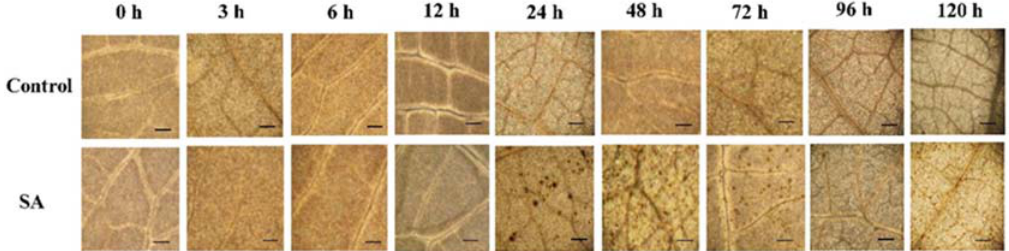
Figure 3. In situ detection of H 2 O 2 using 3,3 ′ -diaminobenzidine (DAB) staining on rubber tree leaves after treatment with 5 mM SA. The rubber tree leaves were sprayed with either DW as a control or 5 mM SA. Leaf pieces were collected and stained after treatment at different time points (0, 3, 6, 12, 24, 48, 72, 96 and 120 h). Pictures represent three independent biological replicates. The dark brown precipitates indicate the presence and distribution of H 2 O 2 in plant cells, which could be visualized using a light microscope (scale bars = 100 μ m).